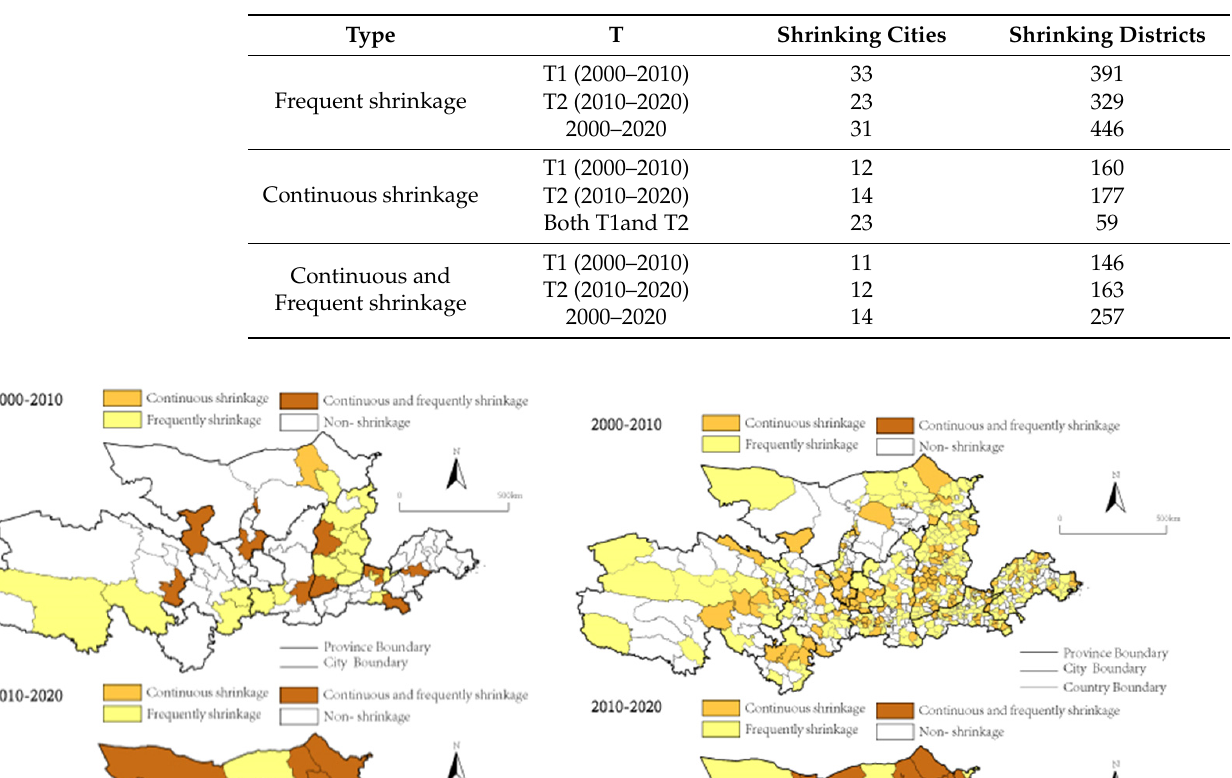
Table 3. Shrinkage numbers during different time spans in Yellow River Basin under the night light dimension.